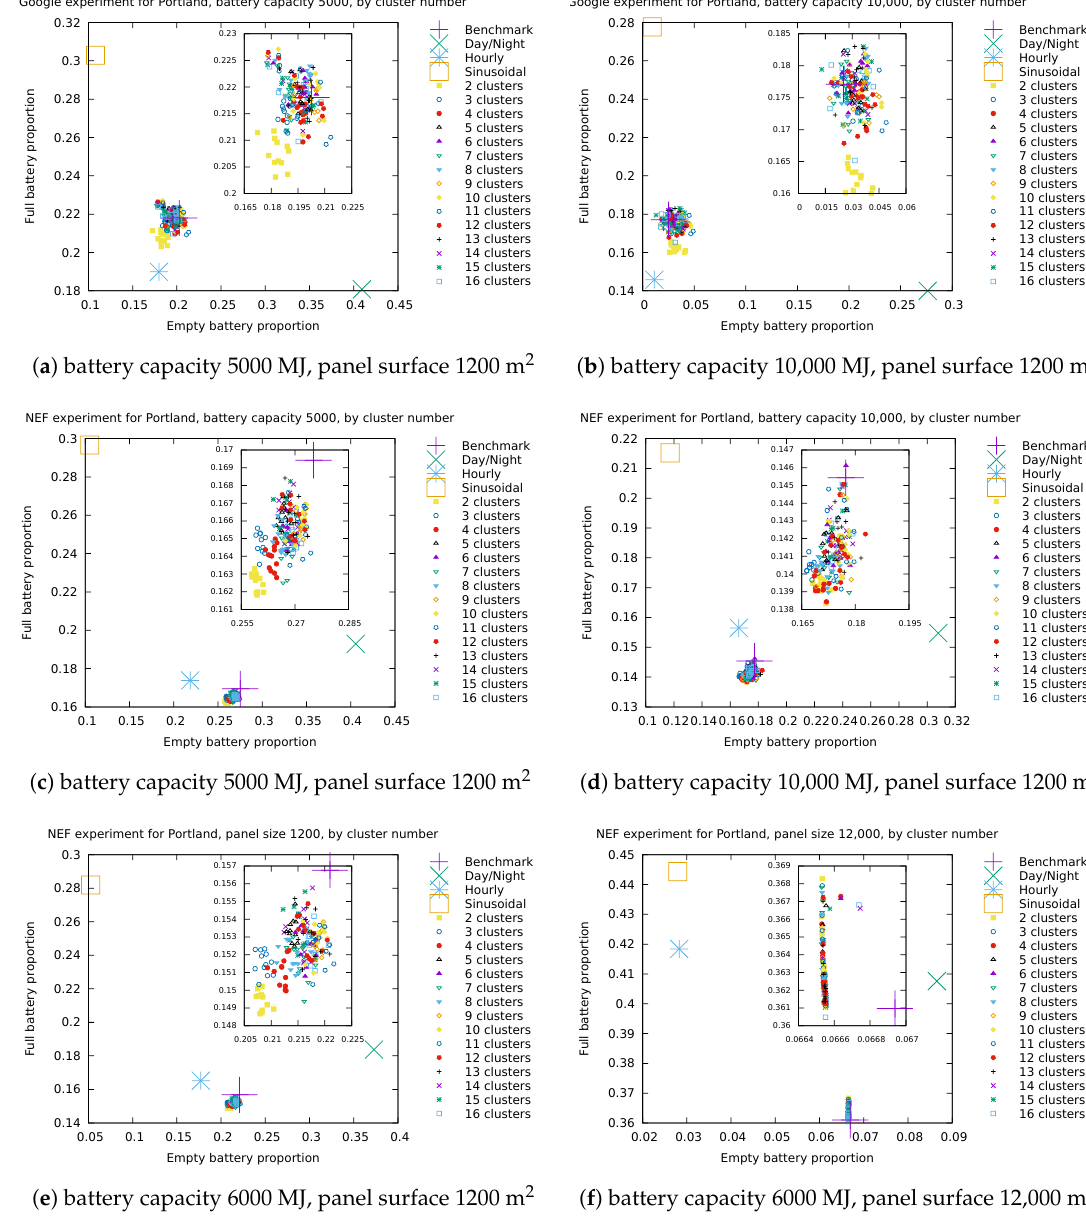
Figure 12. Portland experiments with Google consumer ( a , b ) and NEF consumer ( c – f